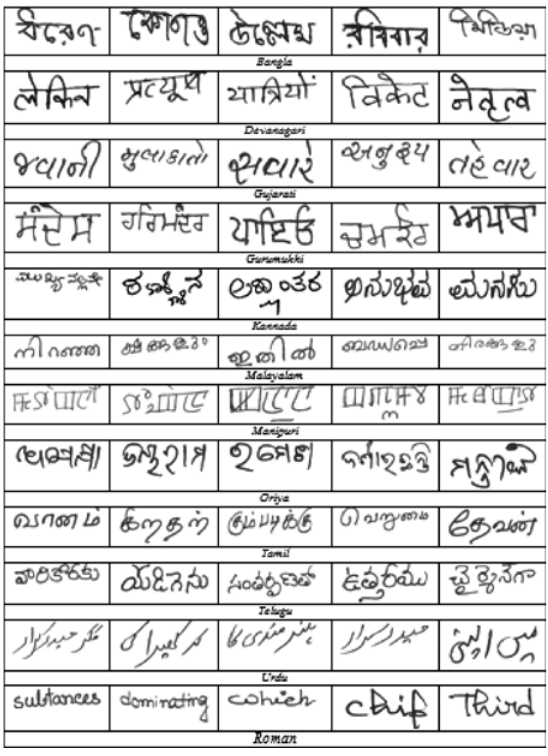
Figure 7: Sample Handwritten Word Images Written in 12 Indic